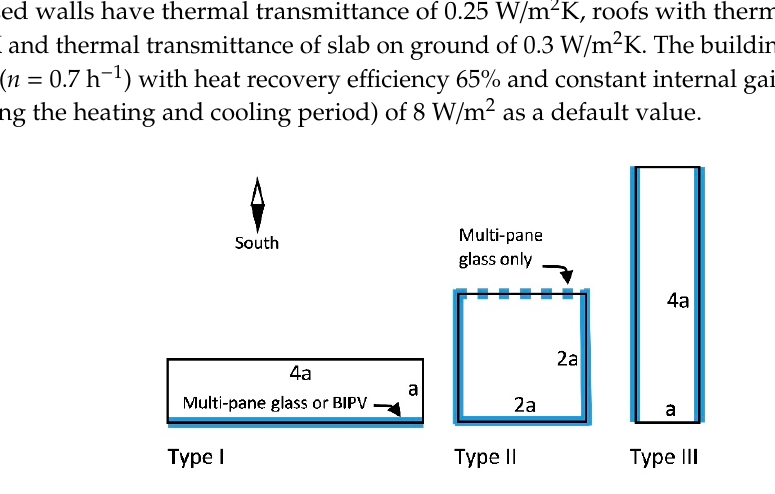
Figure 3. Reference buildings used for validation of regression models.